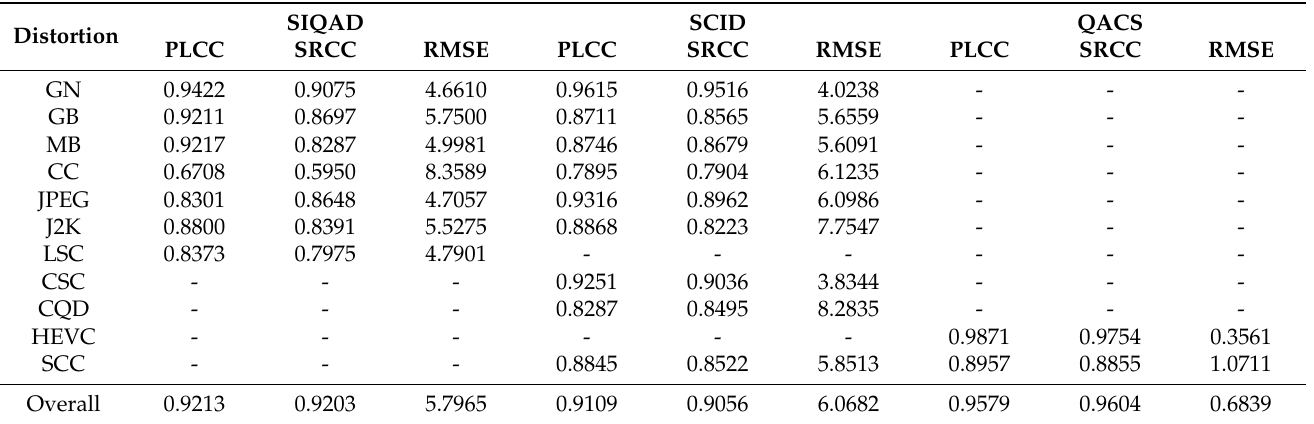
Table 3. PLCC, SRCC, and RMSE values of the proposed method for different distortion types on the SIQAD, SCID, and QACS